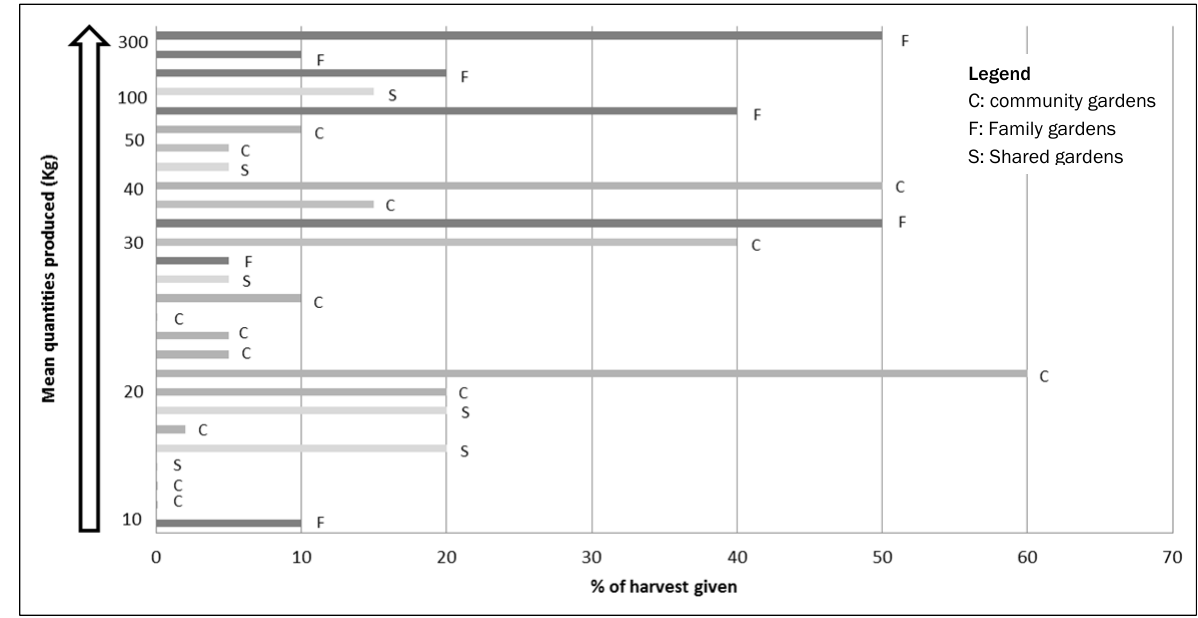
Figure 7. Quantities of Fruit and Vegetables Produced According to Percentage of Harvest Given Away Outside the Immediate